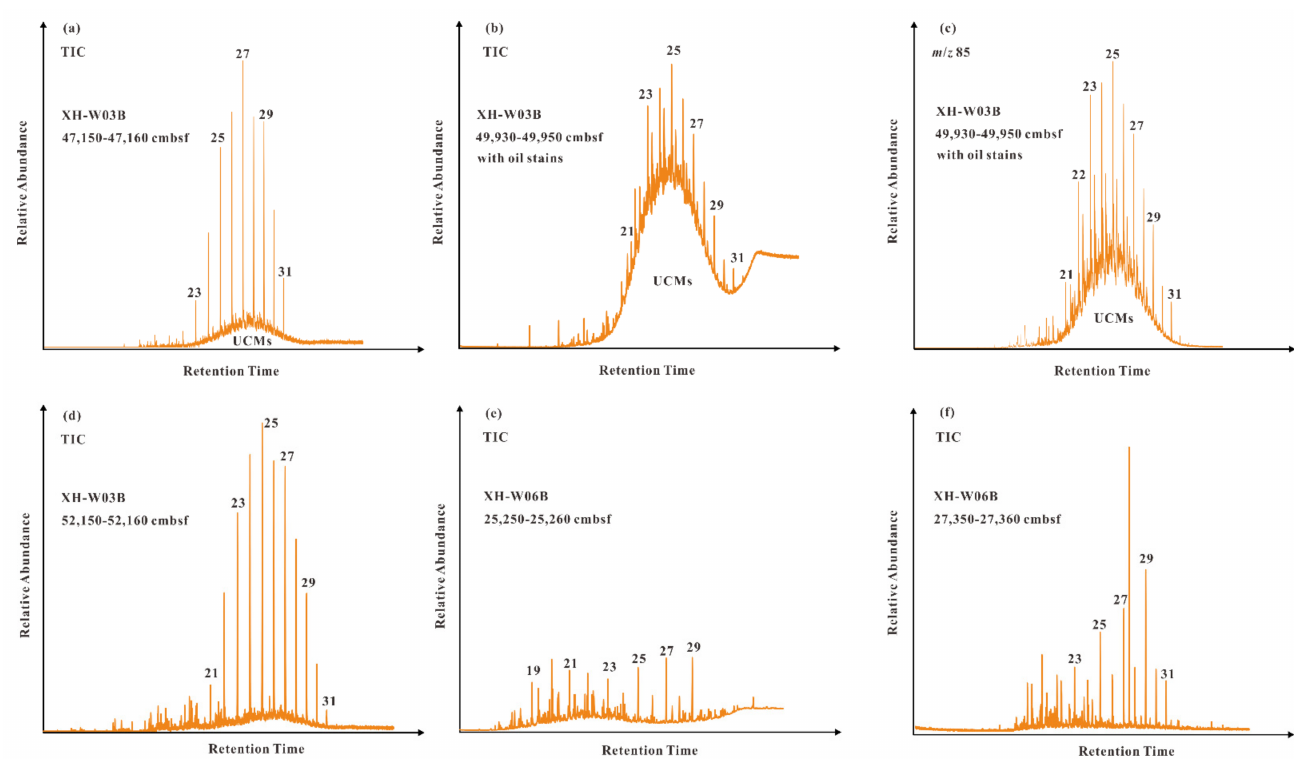
Figure 4. GC-MS chromatograms showing the distribution of n -alkanes in sediments from ( a – d ) core GMGS4-XH-W03B and ( e , f ) core GMGS4-XH-W06B. ( a , b ) and ( d – f ) represent total ions chromatograms; ( c ) represent chromatogram of fragment ion m / z 85. Arabic numerals indicate the numbers of carbon